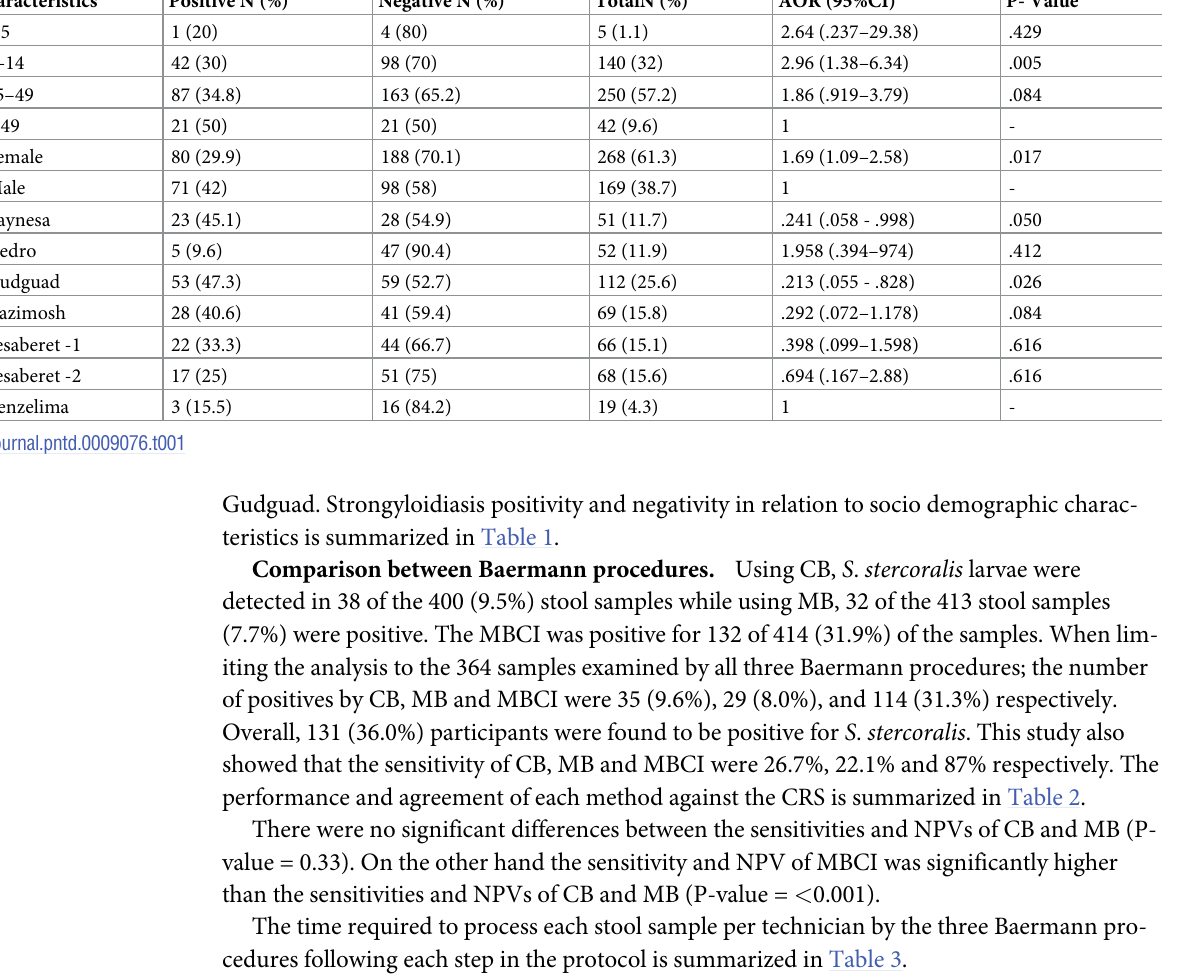
Table 1. Strongyloidiasis Positivity and Negativity in relation to demographic characteristics. Socio demographic characteristics